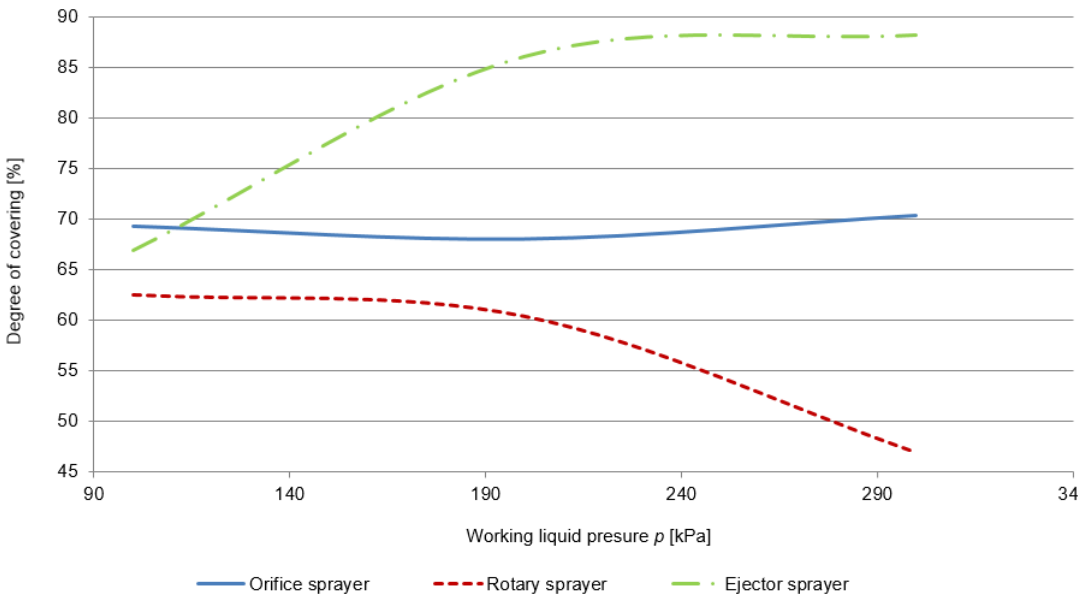
Figure 7. The degree of seed potato covering with the dressing substance for the electronically controlled sprayer valve with an additional supply of compressed air positioned at a distance S of 50 mm from the seed potato fall axis.